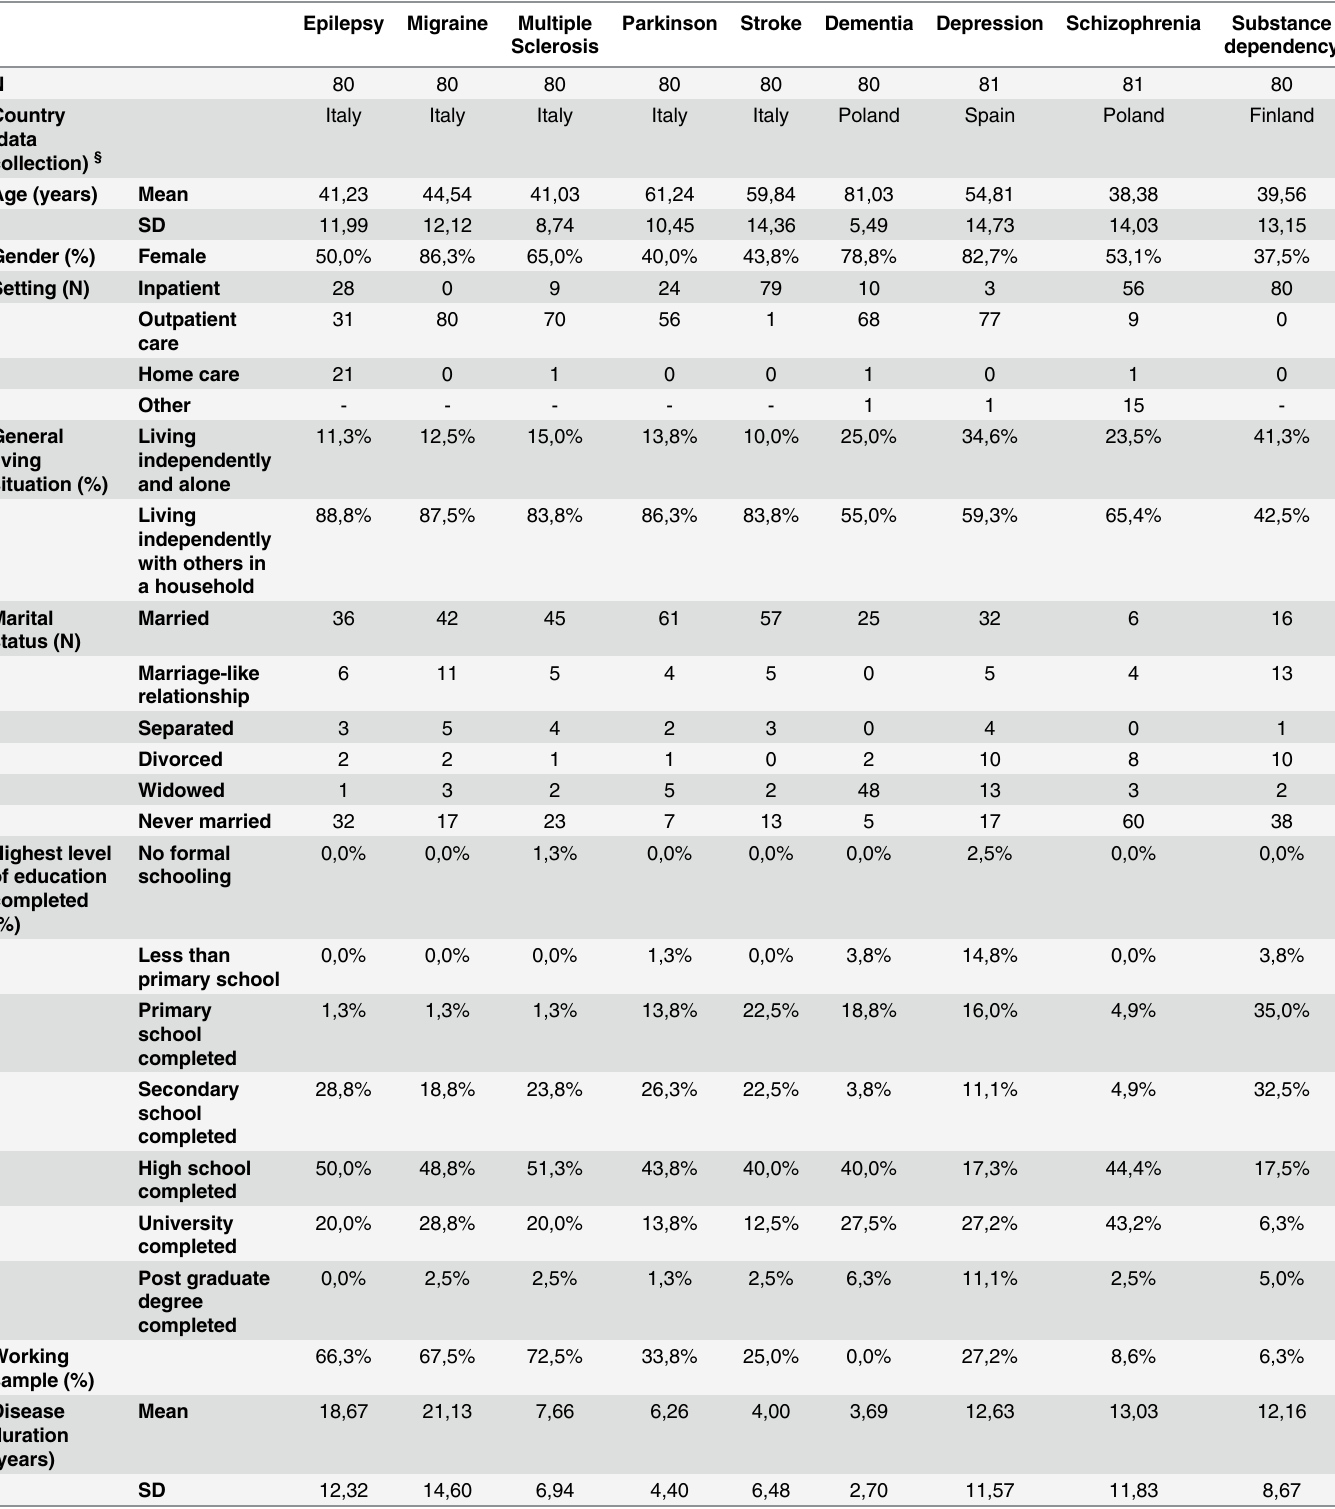
Table 2. Demographic characteristics of the persons participating in the study implementing the PARADISE data collection